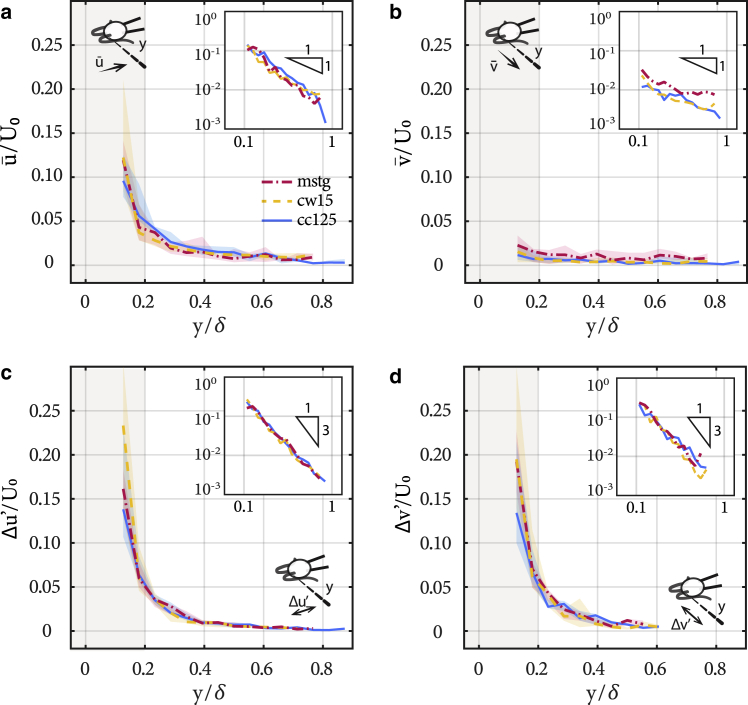
Hydrodynamics of beating flagella from optical tweezers-based velocimetry (OTV). (a and b) Relationship between average (a) axial u¯ and (b) lateral v¯ flows and distance y from the midplane of the cell. (c and d) Relationship between flow amplitudes in (c) axial Δu′ and (d) lateral Δv′ directions and distance y. The red dash-dot line is for mstg(N=9), the yellow dashed line is for cw15(N=11), and the solid blue line is for cc125(N=14) cells. The lines represent the median, whereas the shaded region represents the interquartile. The distance y is normalized by δ=ν/f0, where ν is the kinematic viscosity of water. Insets show data plotted in log-log scale to highlight the rates of spatial decay for the flows. To see this figure in color, go online.